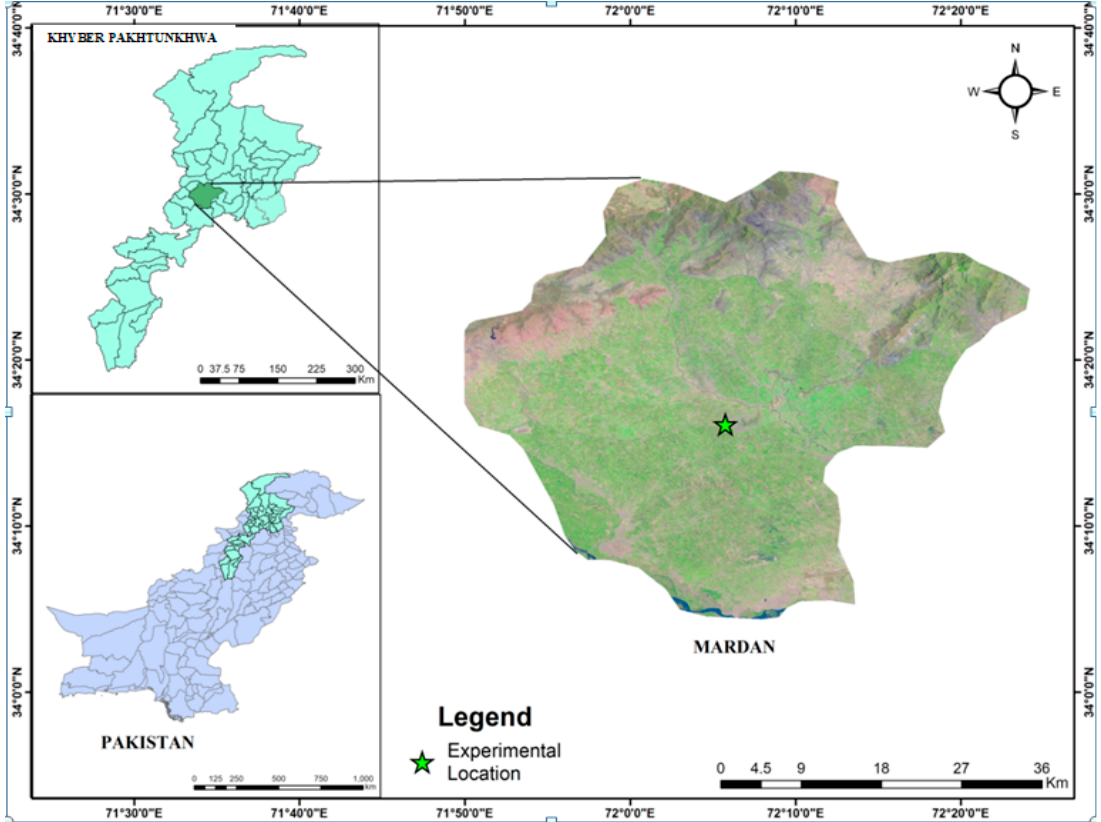
Figure 1. Study area map. (Adopted from Fawad and Khan [9]).